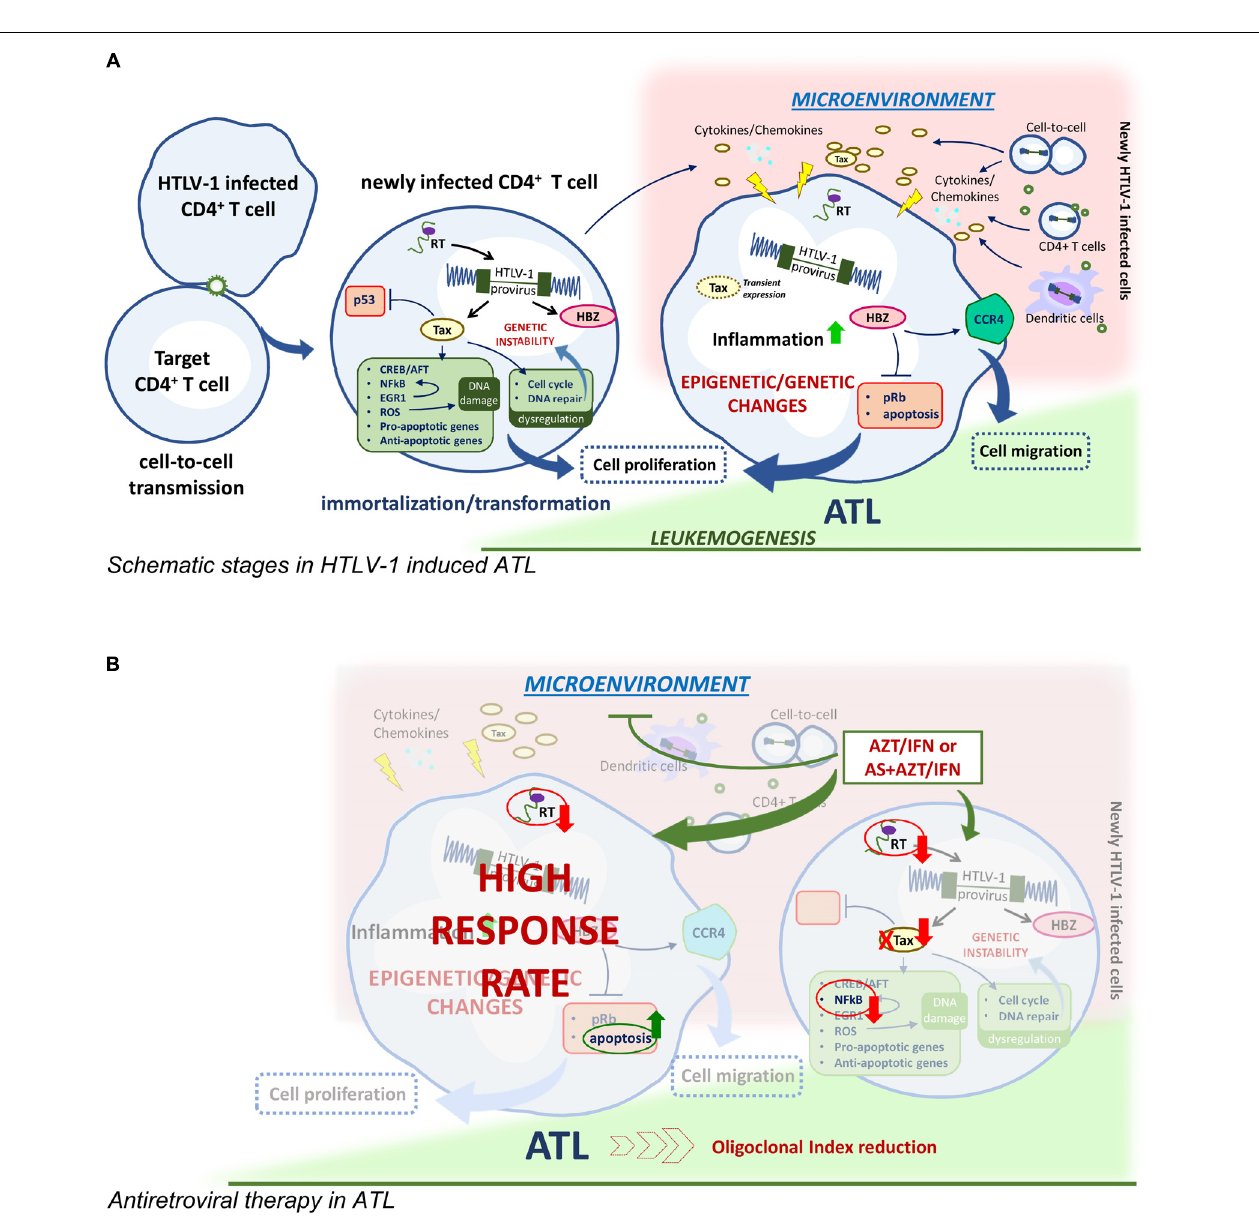
FIGURE 1 | HTLV-1 driven leukomogenesis and possible mechanism of antiviral therapy. (A) Main immortalization/transformation process activated by HTLV-1 regulatory protein Tax and HBZ in newly infected CD4+ cells transmit virus to uninfected CD4+ cells and leading to epigenetic and genetic changes in ATL transformed cells. Cell migration and cell-to-cell virus transmission, presumably involving also dendritic cells, favor the release of inflammatory cytokines and chemokines milieu in the microenvironment and contribute to the maintaining of the infected clones. (B) AZT/IFN with or without arsenic trioxide (AS) could interrupt the maintaining route of